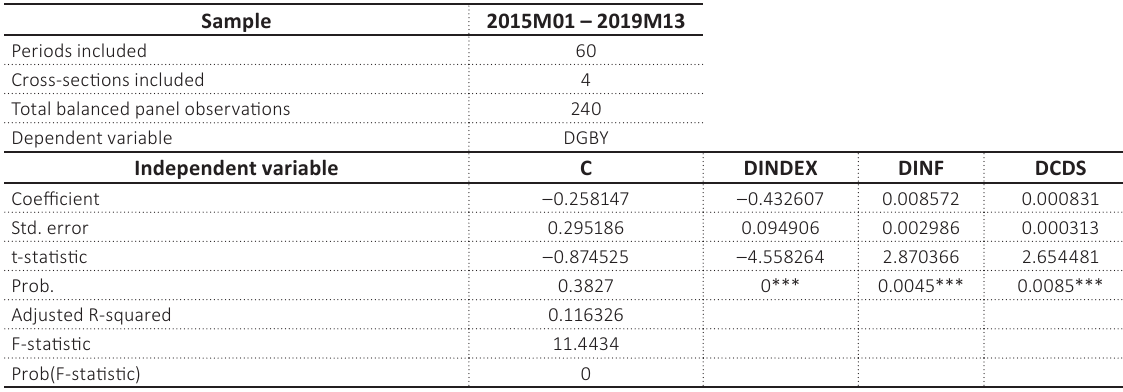
Table 3. Cross-section test equation for the random effect for Model